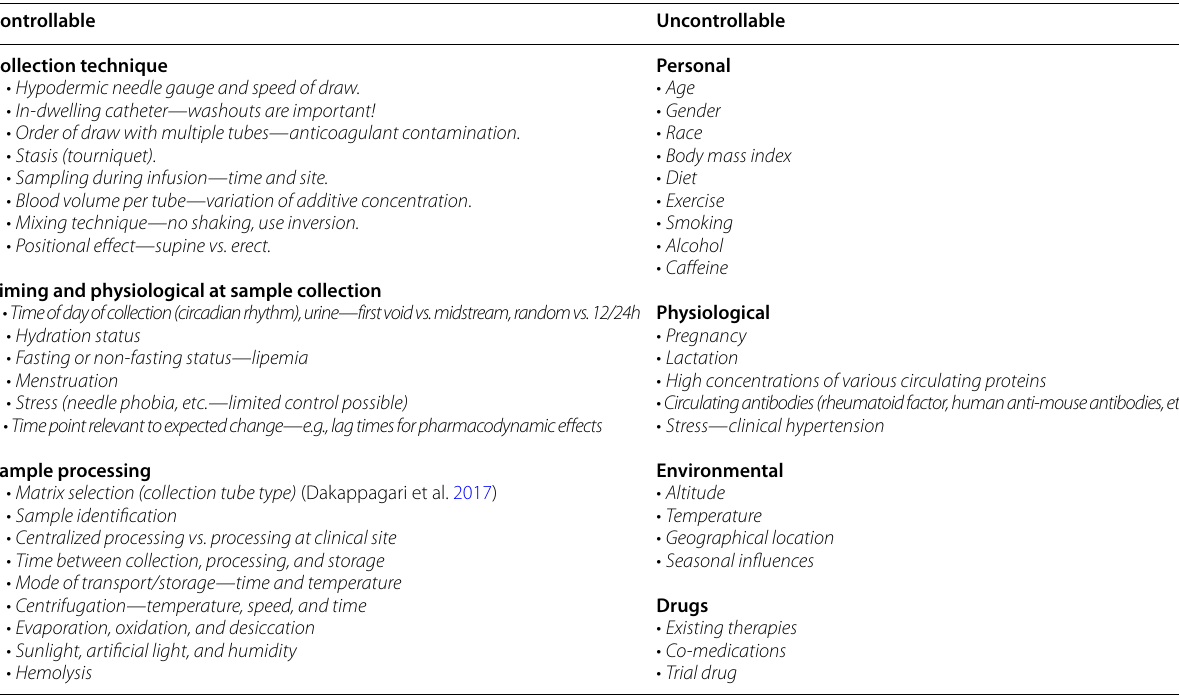
*Adapted from John Allinson’s presentation